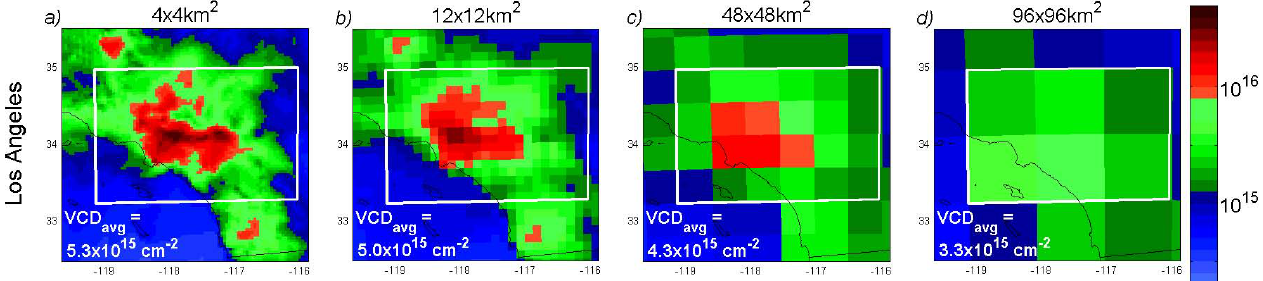
Fig. 8. WRF-CHEM 3–7 July 2006, 1p.m.LST average NO 2 column (moleculescm − 2 ) simulated over Los Angeles at (a) 4km, (b) 12km, (c) 48km, and (d) 96km model resolution. NO 2 column is averaged over a sub-domain (white box) and reported at the bottom of each